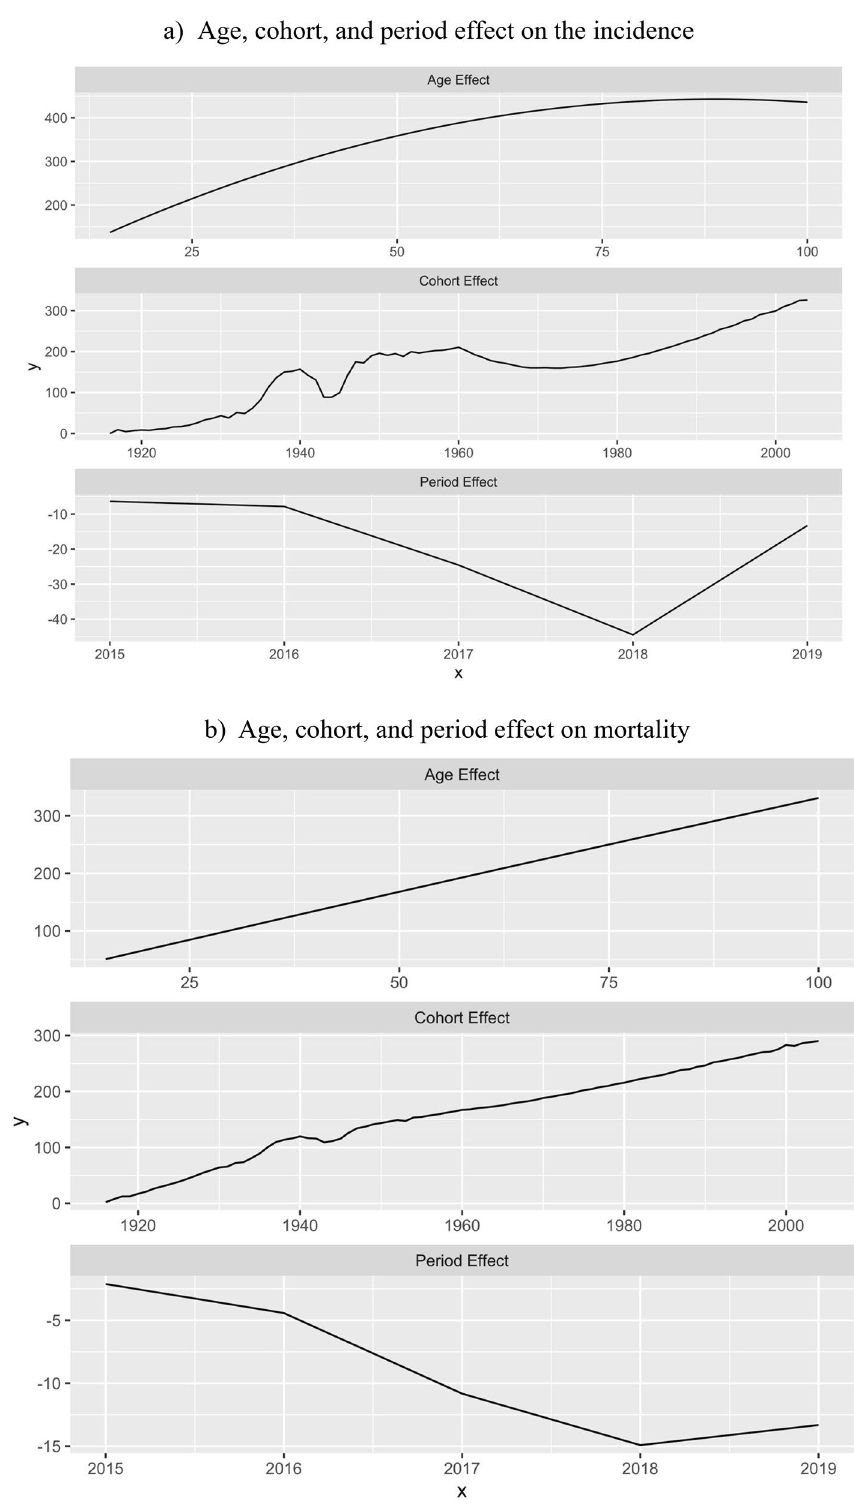
Figure 2. Age-period-cohort analysis: ( a ) Age, cohort, and period effect on incidence ( b ) Age, cohort, and period effect on